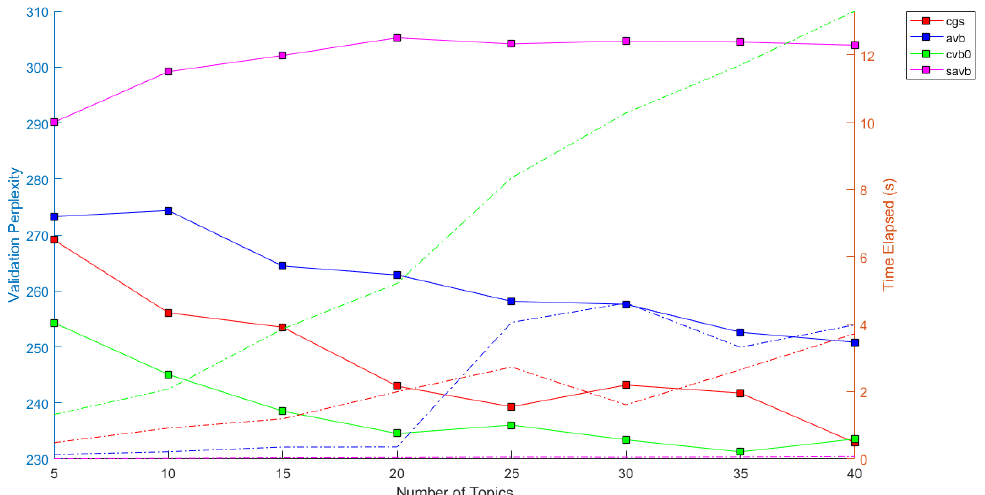
Figure 6. “Perplexity” trend (vertical axis on the left—continuous lines), time elapsed trend (vertical axis on the right—dashed lines), topics ranging between 5 and 40 (horizontal axis), and for 4 LDA inference algorithms ( cgs —red lines; avb —blue lines; cvb0 —green lines; savb —magenta lines).